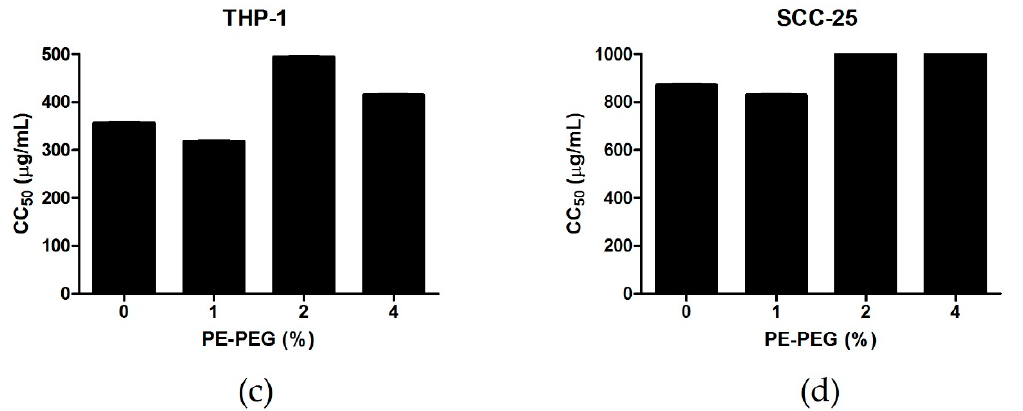
Figure 2. Cytotoxicity of different SLN suspensions in THP-1 and SCC-25 cell lines. ( a ) THP-1 cells were seeded into 96-well culture plates at 2 × 10 4 cells/well. Then, different concentrations of non-coated SLN (0%) ( • ) or SLN coated with different percentages of PE–PEG (1% ( (cid:4) ), 2% ( (cid:78) ) or 4% ( (cid:72) )) were added to cell culture. They were incubated for 24 h and cell toxicity was determined by CytoTox 96®Non-Radioactive Cytotoxicity Assay. Cell toxicity (%) was defined as mentioned in Materials and Methods. Results are the mean ± SEM of three independent experiments performed in triplicate. Dose-response curves were plotted using GraphPad. ( b ) SCC-25 cells were seeded into 96-well culture plates at 10 4 cells/well. The next day, different concentrations of non-coated SLN (0%) ( • ) or SLN coated with different percentages of PE–PEG (1% ( (cid:4) ), 2% ( (cid:78) ) or 4% ( (cid:72) )) were added to cell culture and cells were further incubated for 24 h. Cell cytotoxicity was determined by CytoTox 96®Non-Radioactive Cytotoxicity Assay. Cell viability (%) was defined as mentioned in Materials and Methods. Results are the mean ± SEM of five independent experiments performed in triplicate. Dose-response curves were plotted using GraphPad. ( c ) CC 50 of different SLN suspensions were obtained from dose-response curves in THP-1 cell culture. ( d ) CC 50 of different SLN suspensions were obtained from dose-response curves in SCC-25 cell culture.